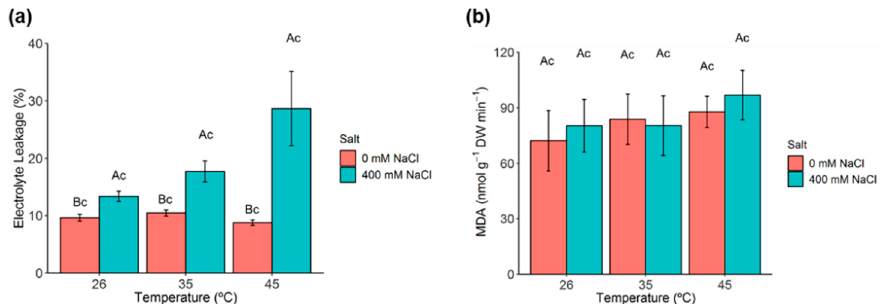
Figure 4. Membrane permeability and lipid peroxidation in C. glauca branchlets under the single and combined exposure to salt (0 and 400 mM NaCl) and temperature (26, 35 and 45 °C) conditions. ( a ) Electrolyte leakage. ( b ) Malonyldialdehyde (MDA) content. Bars represent the mean values ± SE from three to five independent measurements. Two-way ANOVA ( p < 0.05) followed by Tukey’s HSD test was performed for means comparison, and different letters express significant differences between [NaCl] for the same temperature (A, B) or between temperature for the same [NaCl] (c) with A and c representing the highest values.